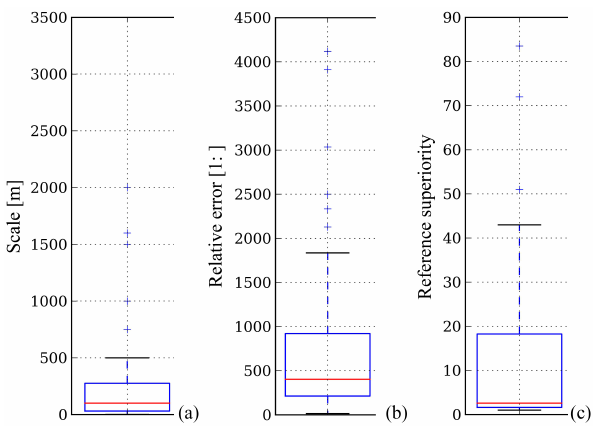
Figure 4. Box plots summarising statistics: (a) of the scale of the study reaches (N: 56; ID 1–3 and 5–39 in Appendix A), (b) the rel- ative error (calculated in regard to distance and measured error, N: 54; ID 1–3, 5–12 and 14–39 in Appendix A), and (c) the reference superiority (calculated in regard to measured error and reference er- ror, N: 33; ID 1–30 and 32–39 in Appendix A) of reviewed studies.